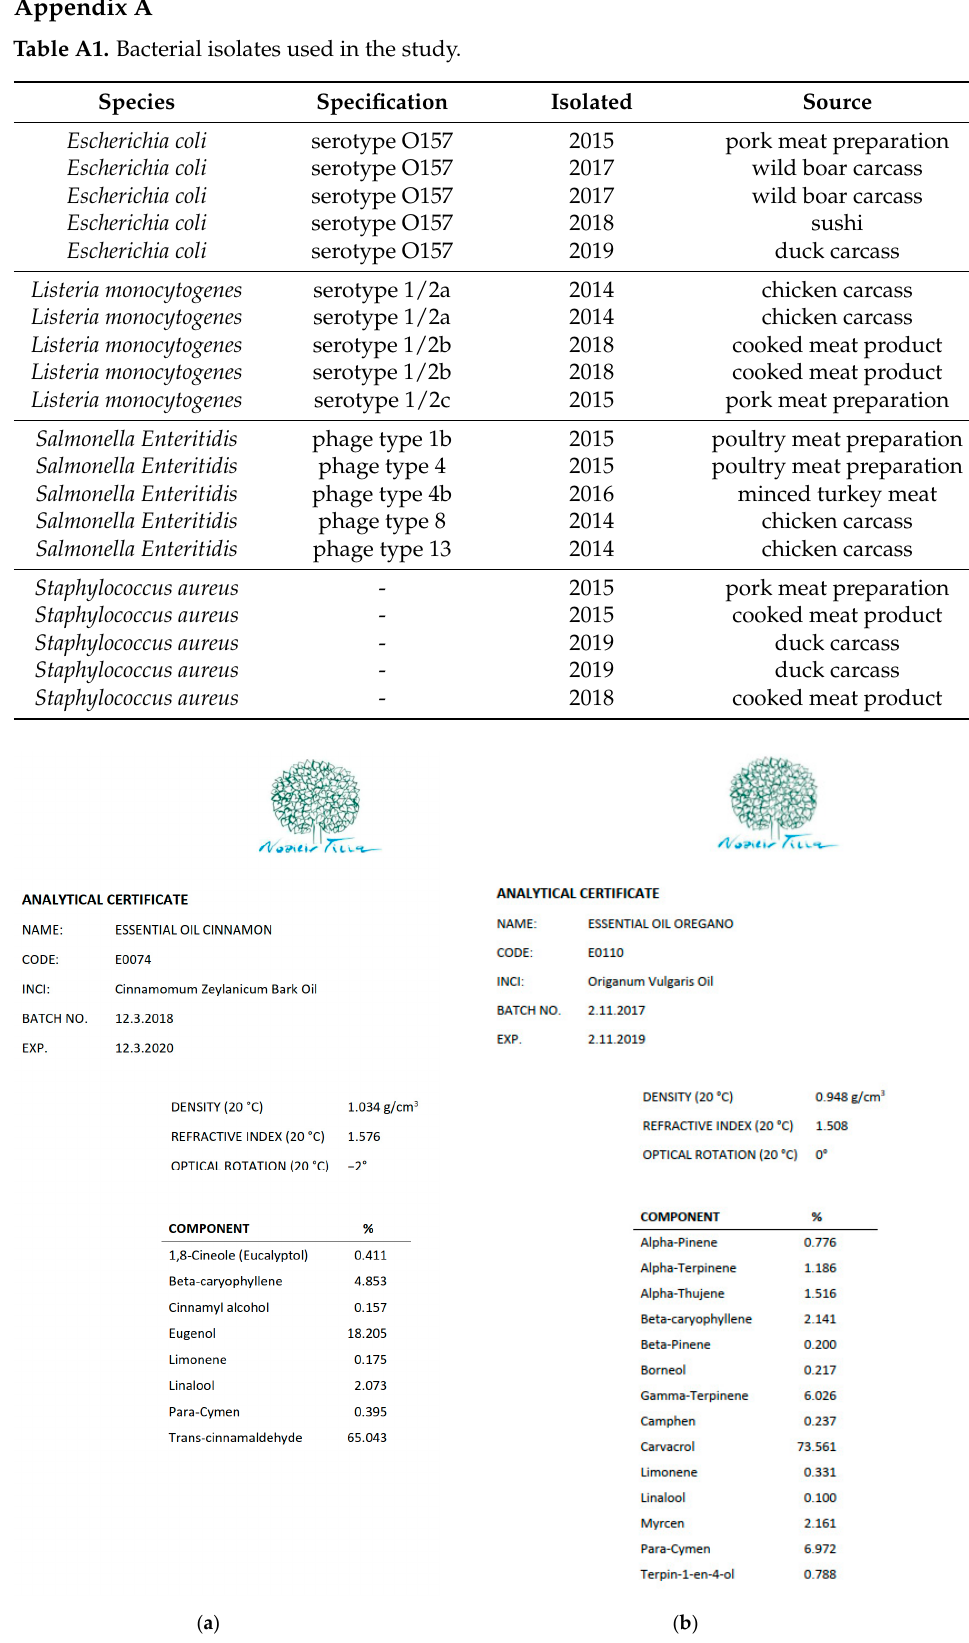
Figure A1. Analytical certificates. ( a ) chemical composition of cinnamon essential oil; ( b ) chemical composition of oregano essential oil.